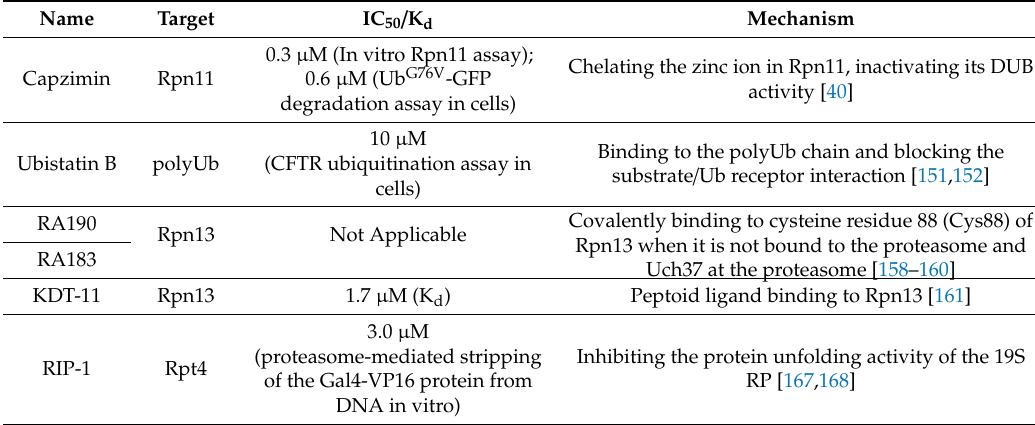
Table 3. Inhibitors of non-20S UPS